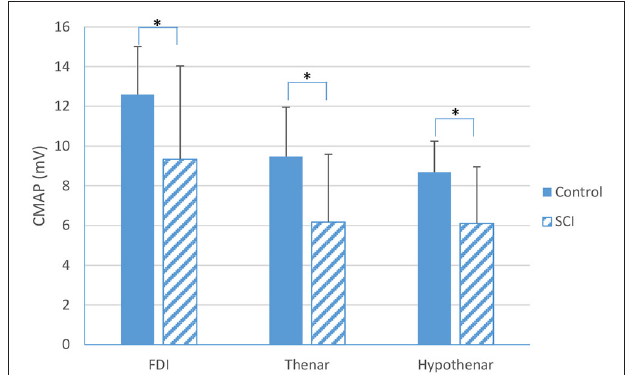
FIGURE 1 | A comparison in Compound Muscle Action Potential (CMAP) between SCI and neurologically intact subjects for the FDI, thenar and hypothenar muscles (mean ± standard deviation, *indicates p < 0.05) .